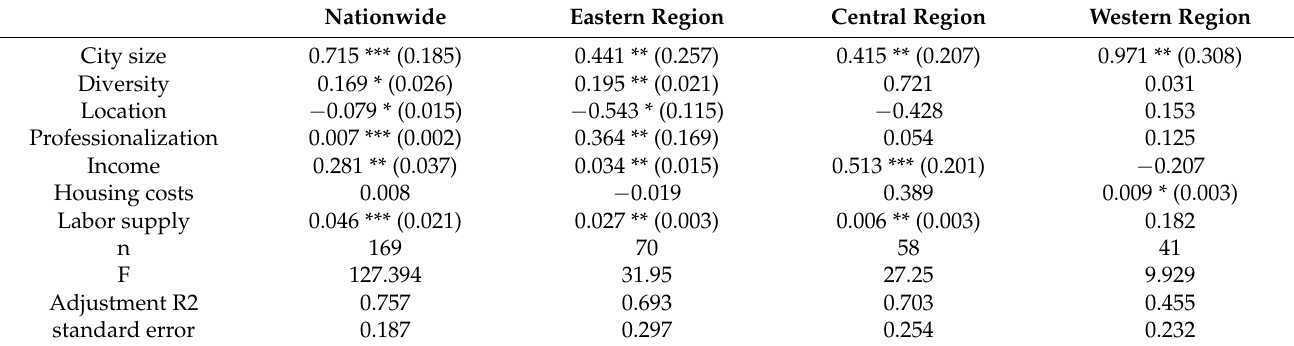
Table 4. The regression results of influencing factors of employment